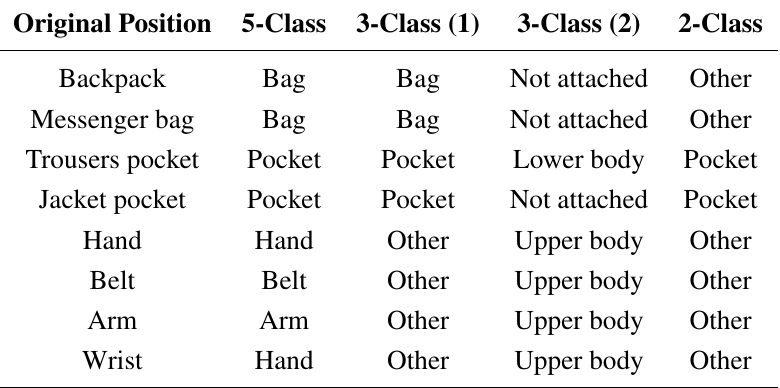
Table 9. Reduction of classes.